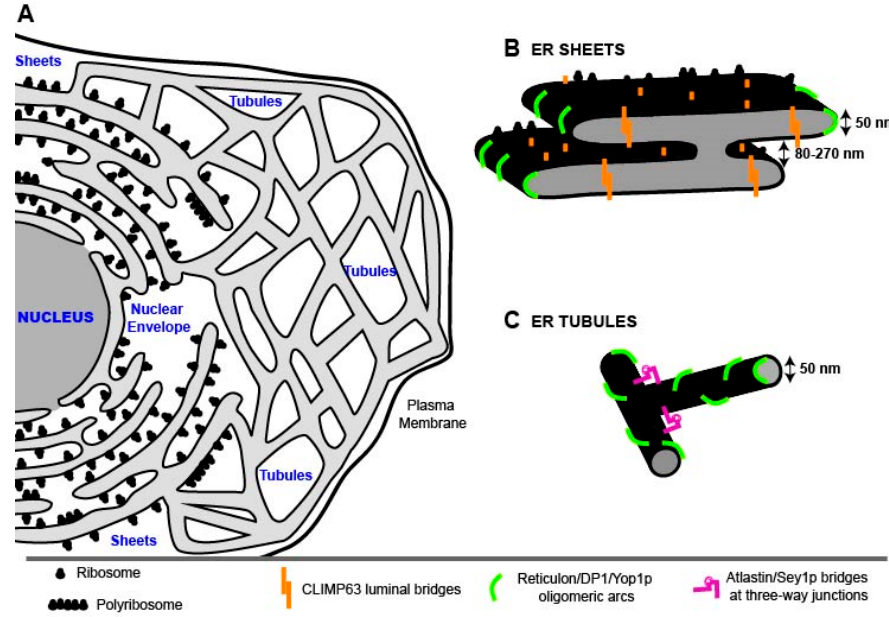
Figure 1. Schematic representation of the endoplasmic reticulum (ER) network organization. ( A ) The ER network comprises the nuclear envelope (NE) and the peripheral ER. The peripheral ER is composed of stacked sheets, studded with ribosomes, and tubules extending the reticular network to the plasma membrane; ( B ) Schematic of an ER sheet, depicting its multidimensional properties and the ER ‐ shaping proteins that are responsible for the characteristic, flattened morphology. CLIMP63 is a coiled ‐ coil protein forming oligomers bridging across the luminal space of the sheets that are also studded with ribosomes. High membrane curvature at the edges of the sheets is stabilized by reticulon/DP1/Yop1p proteins, forming wedges inside the bilayer and arc ‐ like scaffolds around the edge. Sheets are also connected to neighboring sheets by membranous twists (“Parking garage model”, [7]); ( C ) Schematic of two ER tubules. Reticulon/DP1/Yop1p oligomers might not only determine the size of the sheet edges, but also the diameter of the tubules. These are interconnected through proteins such as atlastins/Sey1p residing at three ‐ way junctions. The models in (B) and (C) are adapted from [8,9]. Dimensions of ER sheets and tubules refer to those found in mammalian cells.